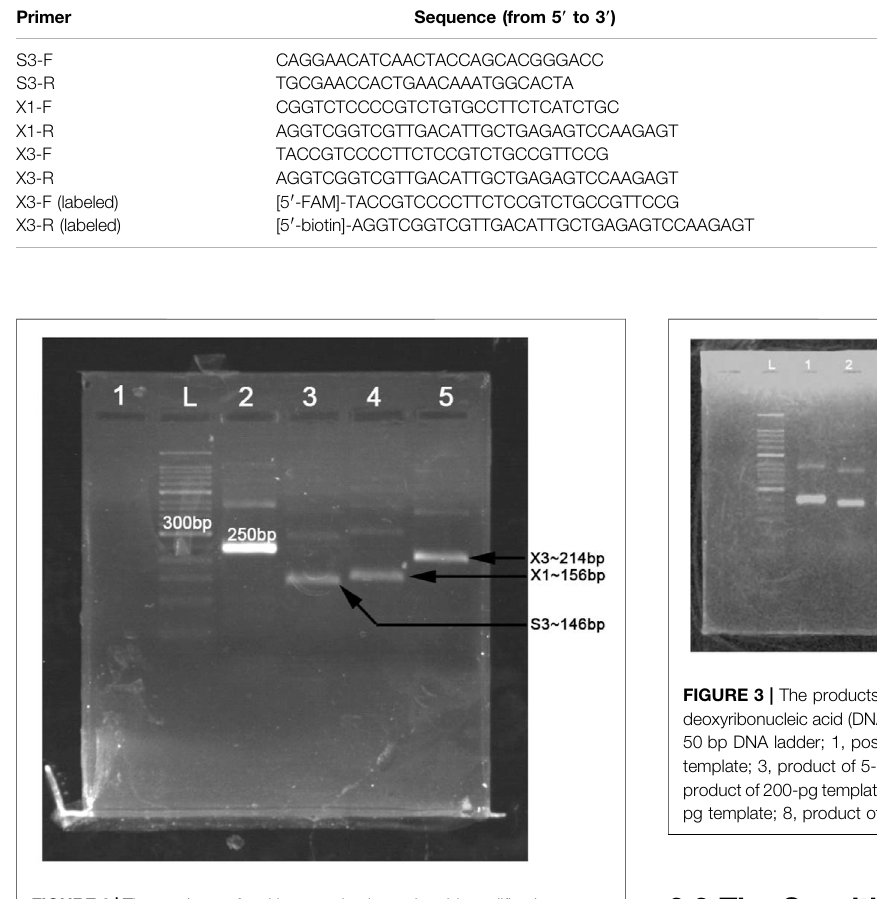
FIGURE 2 | The products of multienzyme isothermal rapid ampli fi cation (MIRA) reaction measured in 2% agarose gel electrophoresis. L, 50-bp DNA ladder; 1, negative control; 2, positive control ( ∼ 250 bp); 3, product of primer S3( ∼ 146 bp);4,productofprimerX1( ∼ 156 bp);5,productofprimerX3 ( ∼ 214 bp).